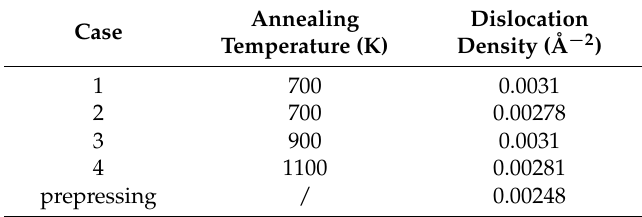
Table 2. Dislocation density at grain boundaries after